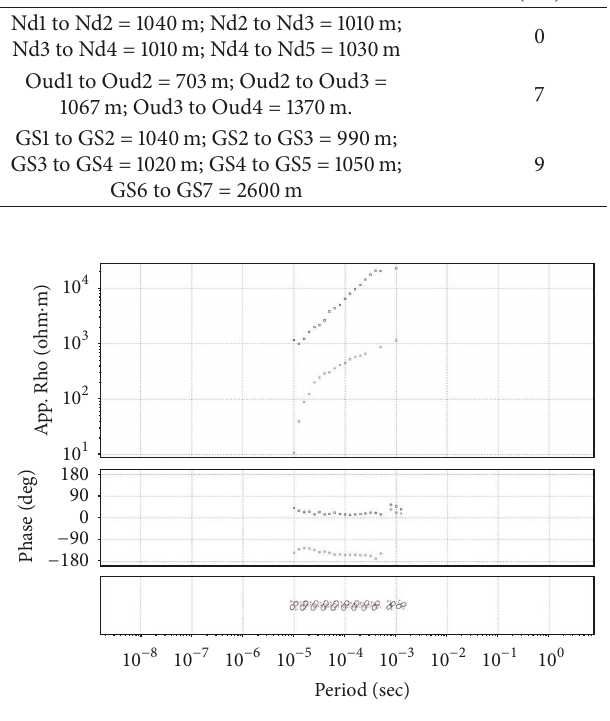
Figure 6: Dimensionality tests (apparent resistivity and phase) of station Oud4 of the Oudou profile [TE mode; TM